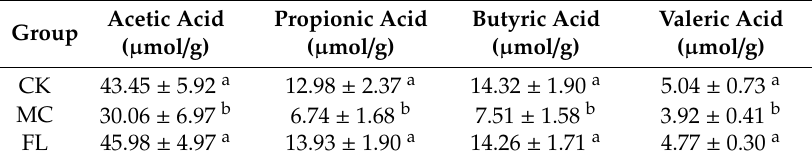
Table 2. Concentration of SCFAs in the feces of each